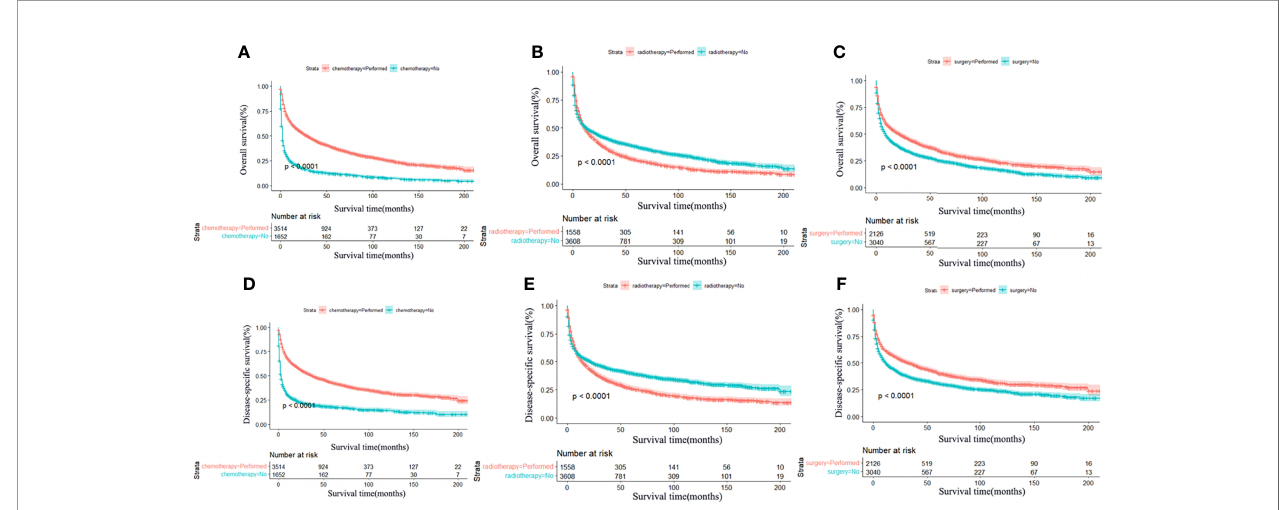
FIGURE 3 | Survival analysis of primary central nervous system lymphoma strati fi ed by treatment: chemotherapy, radiotherapy, and surgery. Signi fi cant statistical difference was found in OS and DSS between patients with chemotherapy and no chemotherapy (A, D) , radiotherapy and no radiotherapy (B, E) , and surgery and no surgery (C, F) , P < 0.0001. Patients who underwent chemotherapy and surgery achieved signi fi cantly longer OS and DSS compared with those who did not. However, radiotherapy led to worse OS and DSS in the long